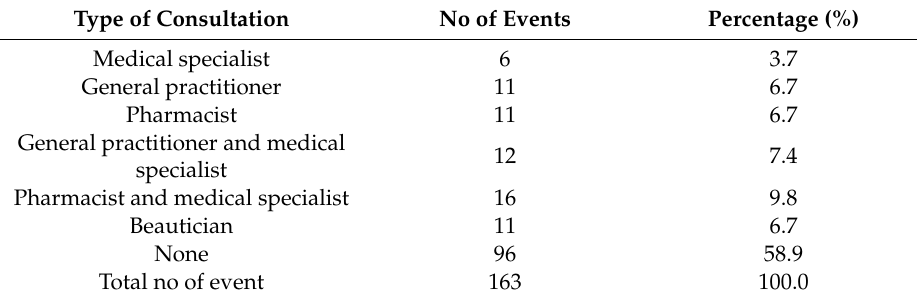
Table 6. Type of consultation